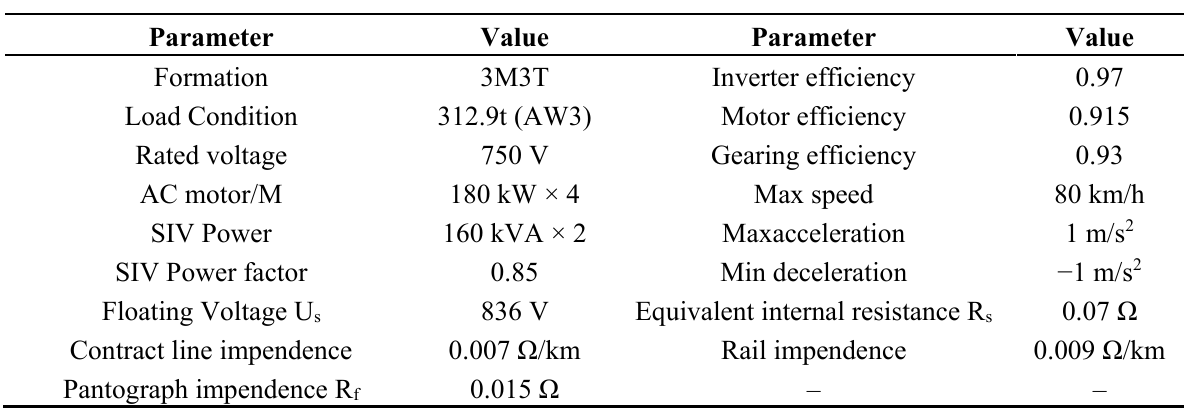
Table 2. Vehicle